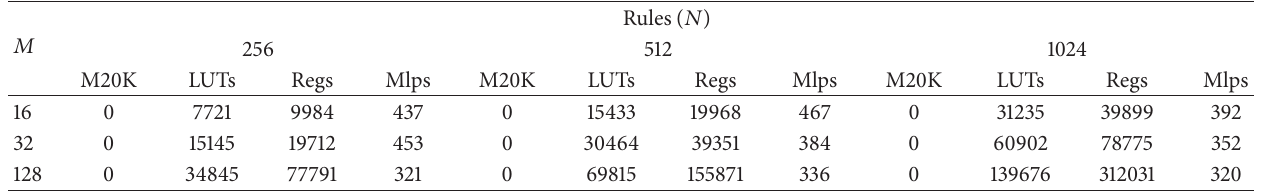
Table 5: Performance of ERM and 2D-pipelined architecture on FPGA ( 𝑚 = 4 , 𝑛 = 8 ).